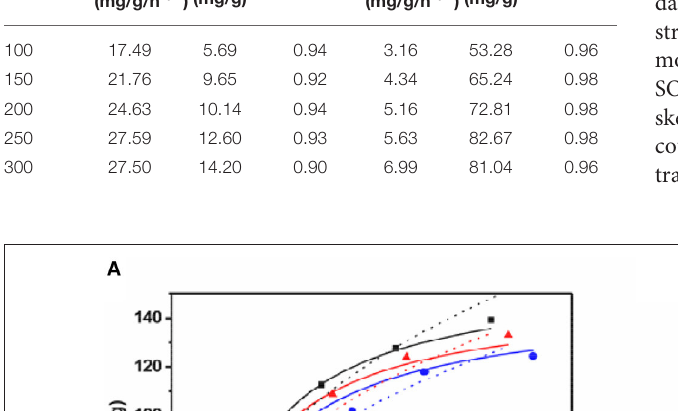
Frontiers in Materials |